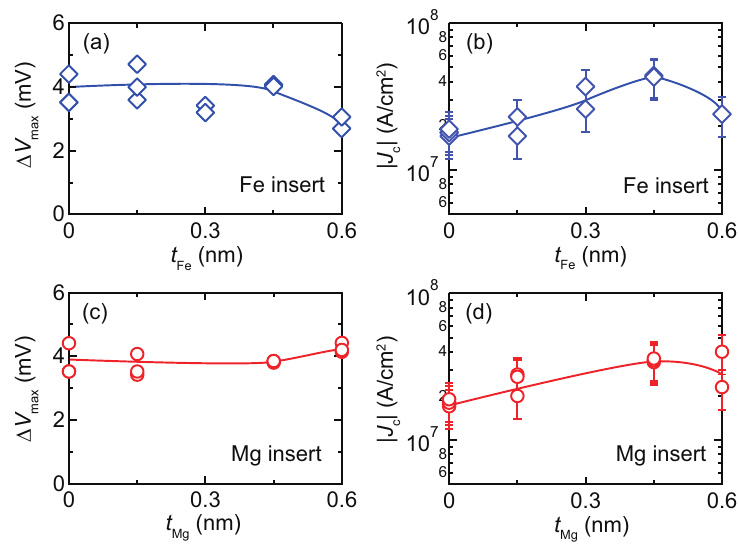
Figure 6. Summaries of ( a , c ) the maximum output voltage, ∆ V max , and ( b , d ) the critical current density J c as a function of the insert thickness. ( a , b ) Fe insert, ( c , d ) Mg